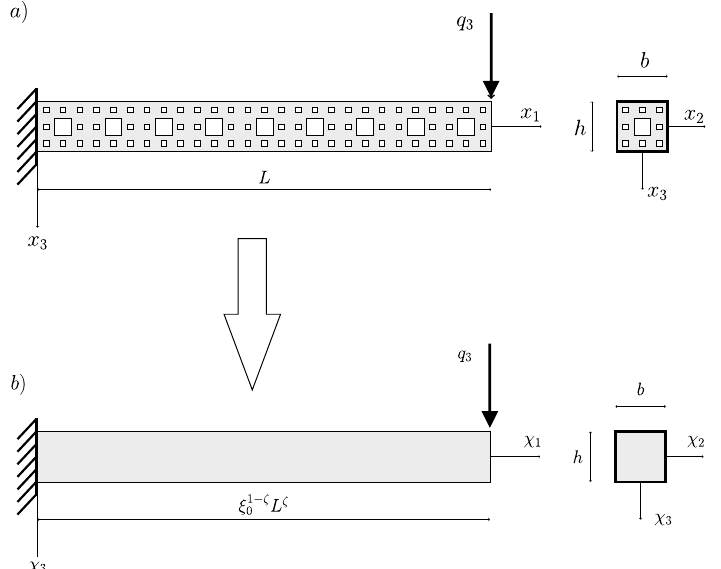
Figure 3. Mapping of the cantilever fractal beam with a load at the free end into the beam made of x ζ , ( a ) fractal beam χ = ξ 1 − ζ fractal continuum x 0 (cid:55)→ 3 3 2.72 ⊂ (cid:60) F